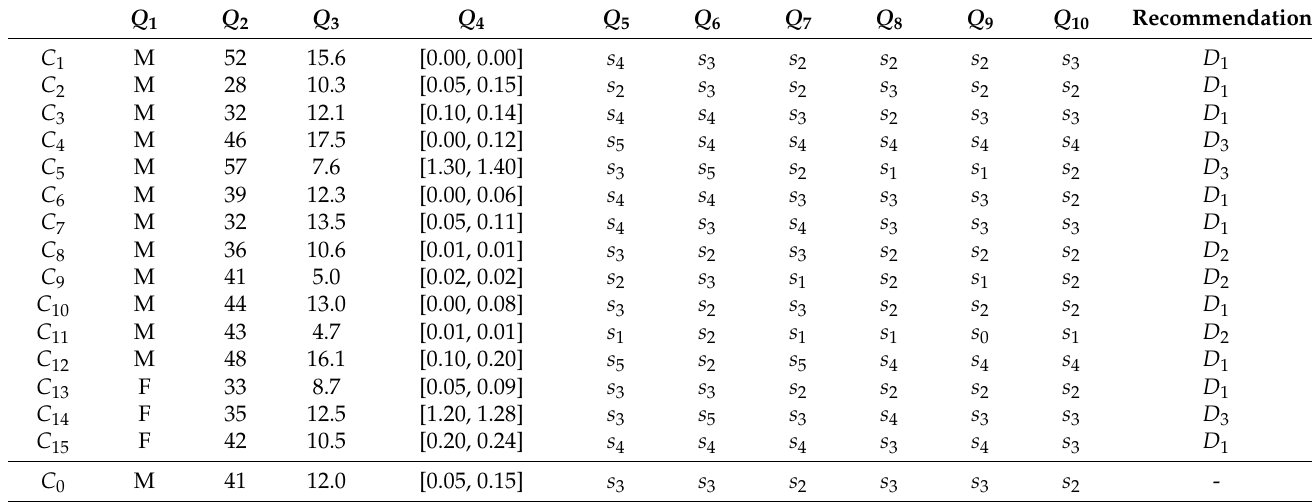
Table 4. Attribute value Q j of historical enforcement cases C i and target enforcement case C 0 .